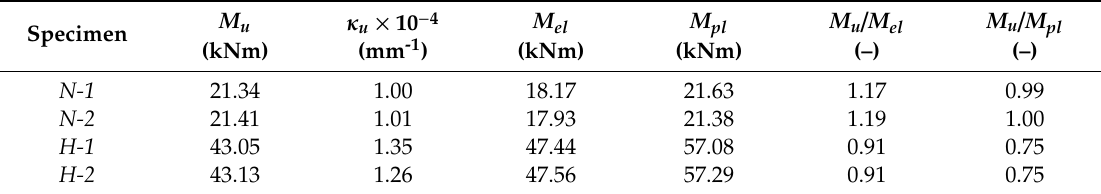
Table 4. Results of the bending